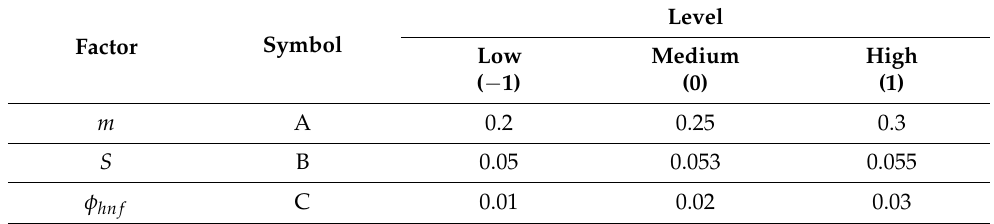
Table 5. Experimental design for the factors and their